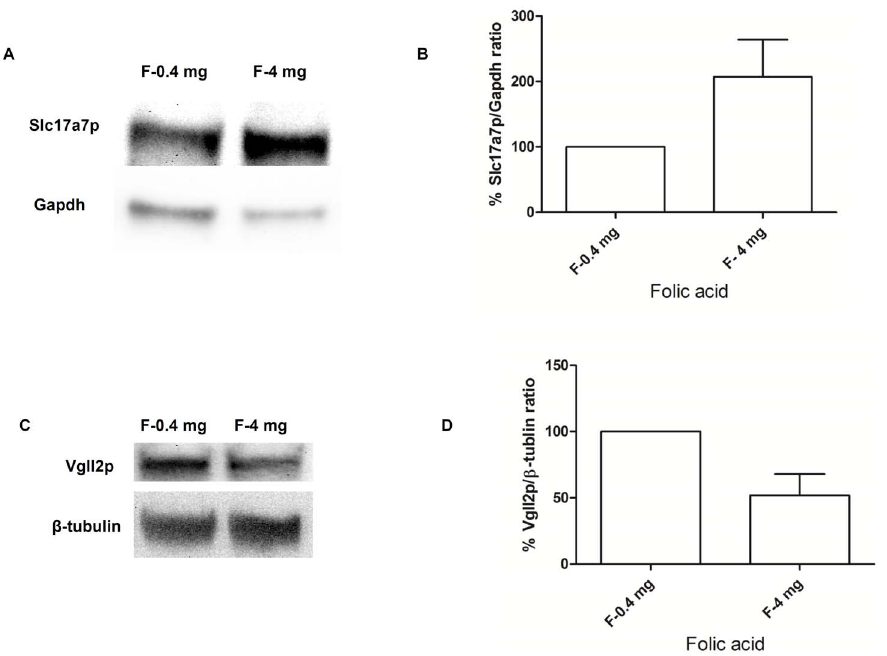
Figure 3. High maternal FA alters the expression of Slc17a7p and Vgll2p in the cerebral hemispheres of female newborn pups. Total cell lysates from the cerebral hemispheres of female (F) newborn pups were prepared from both 0.4 mg/kg and 4 mg/kg FA diet groups and proteins were resolved on 10% Tris/HEPES/SDS-polyacrylamide gels. The blot was probed with Slc17a7p antibody ( A , B ) or with Vgll2p antibody ( C , D ). To confirm equal protein loading, the membranes were re-probed with GAPDH/ b -tubulin antibodies. The left panel represents one representative blot and the right panel shows densitometric evaluation of two independent experiments. Densitometric evaluation of the bands were calculated by using the Image J software and normalized to the densities of GAPDH// b -tubulin. The values corresponding to 0.4 mg/kg FA diet were arbitrarily set to 100%, and the 4 mg/kg values are presented relative to this. The densitometric values represent the mean, and the error bar represents the inter- variability among independent experiments.